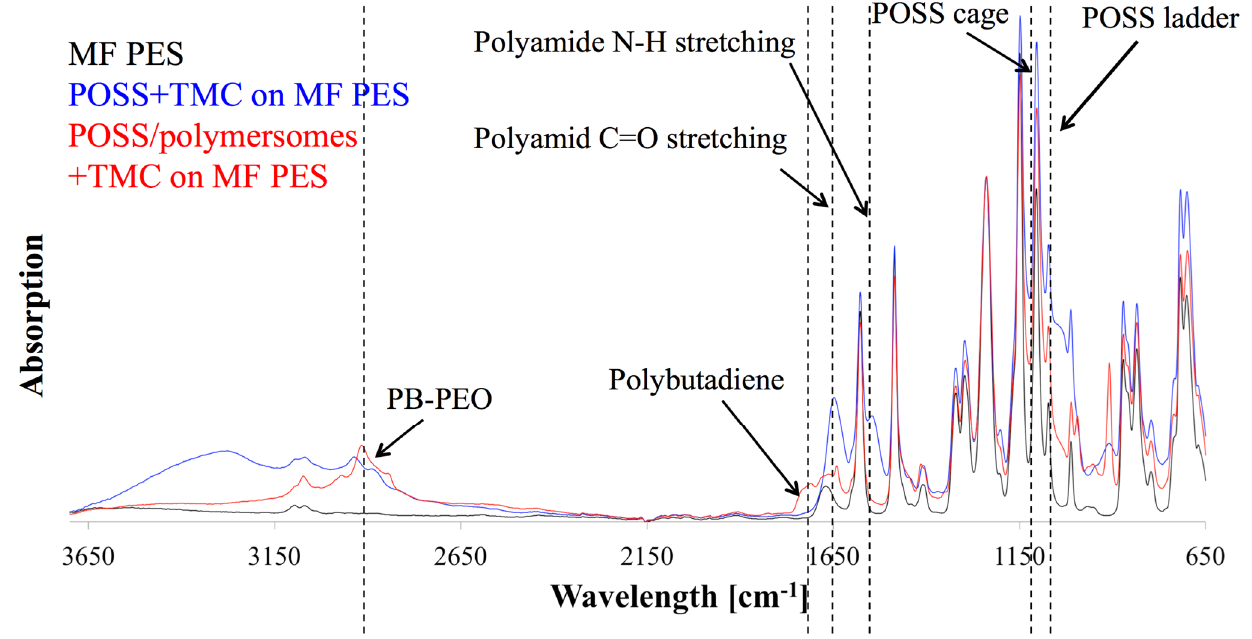
Figure 13. FTIR analysis of supported POSS/polymersomes+TMC AL ( red ) and POSS+TMC control AL ( blue ) on MF PES and pure MF PES ( black ). The PES